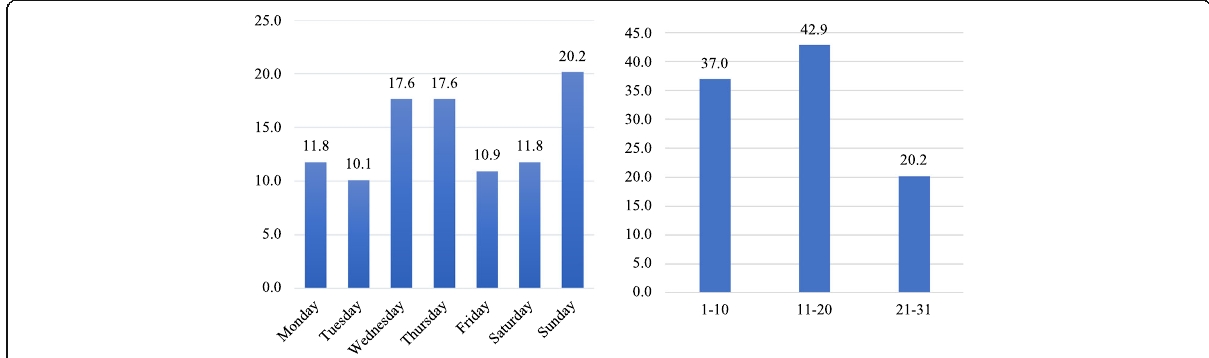
Fig. 5 Percent of days (left) and date interval (right) of death of victims